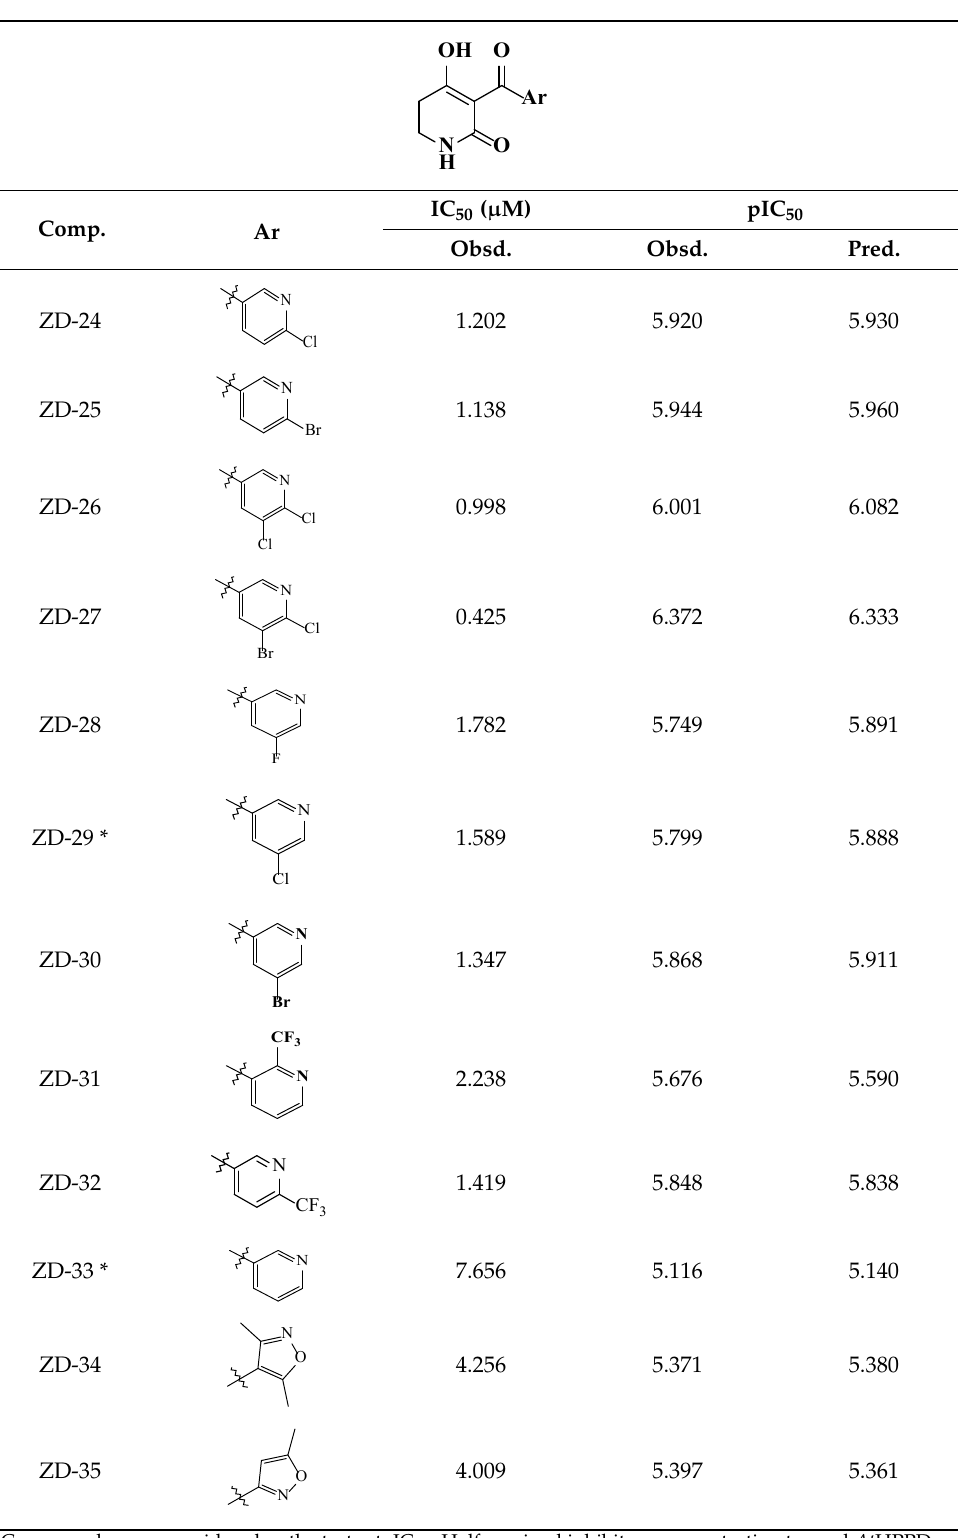
Table 7. Pyridine derivatives used for the Topomer CoMFA